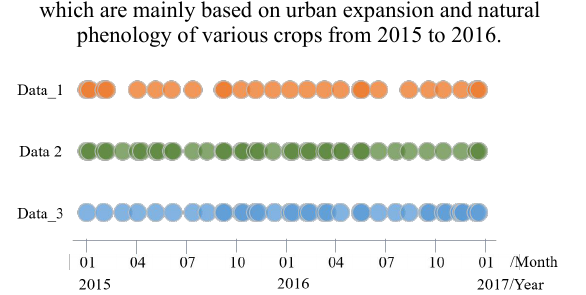
Figure 7. The time distributions of three experimental data sets. Each data set has an average of 1 to 2 scenes per